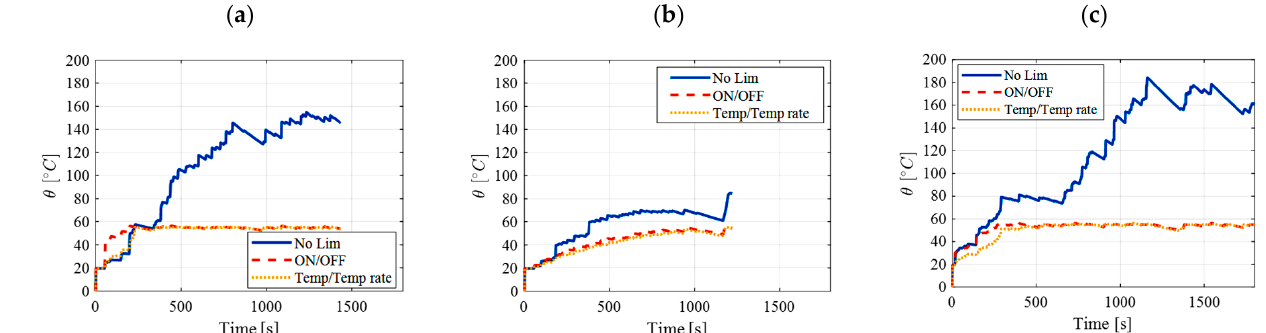
Figure 20. The battery temperature for different temperature limitation strategies and driving cy- cles: ( a ) UDDS; ( b ) NEDC; and ( c ) WLTC. Blue, solid line—No thermal limitation; Orange, dashed line—on/off temperature control; Yellow, dotted line—Temperature and temperature change rate limitation.